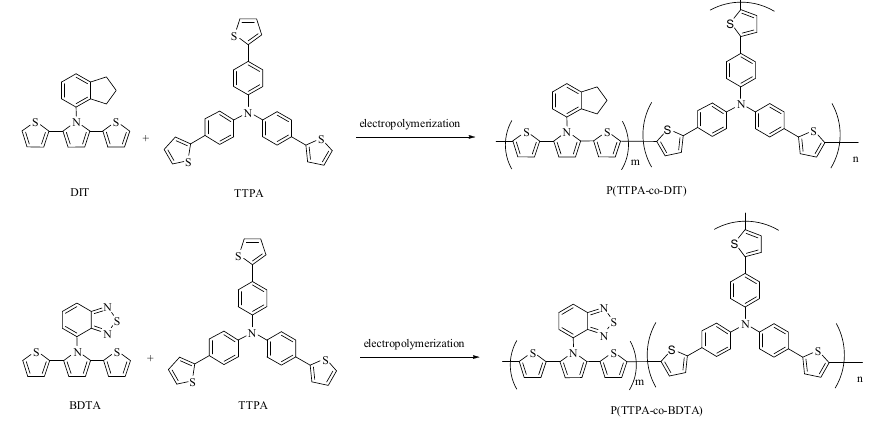
Figure 2. The electrochemical copolymerization of dithienylpyrrole (SNS) derivatives and tris(4-(thiophen-2-yl)phenyl)amine.